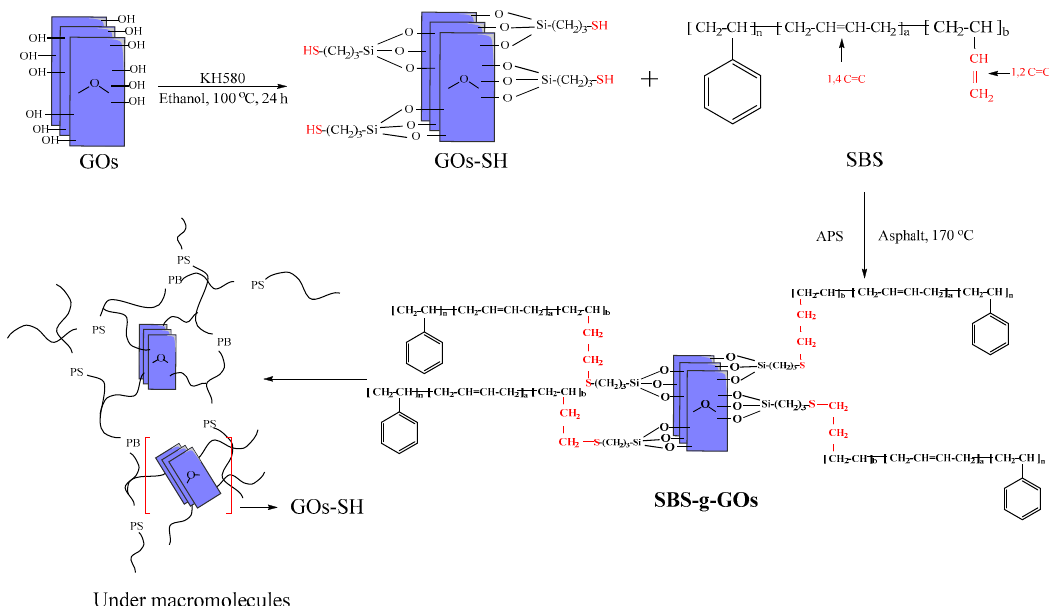
Figure 2. Proposed mechanism of thiol-ene click reaction of SBS-g-GOs.